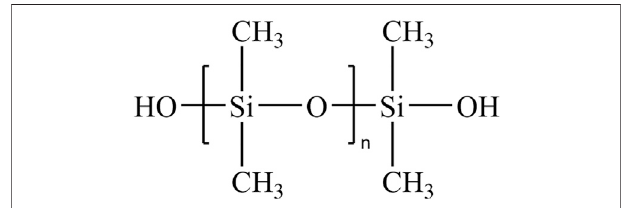
FIGURE 1 | Structure of hydroxyl silicone